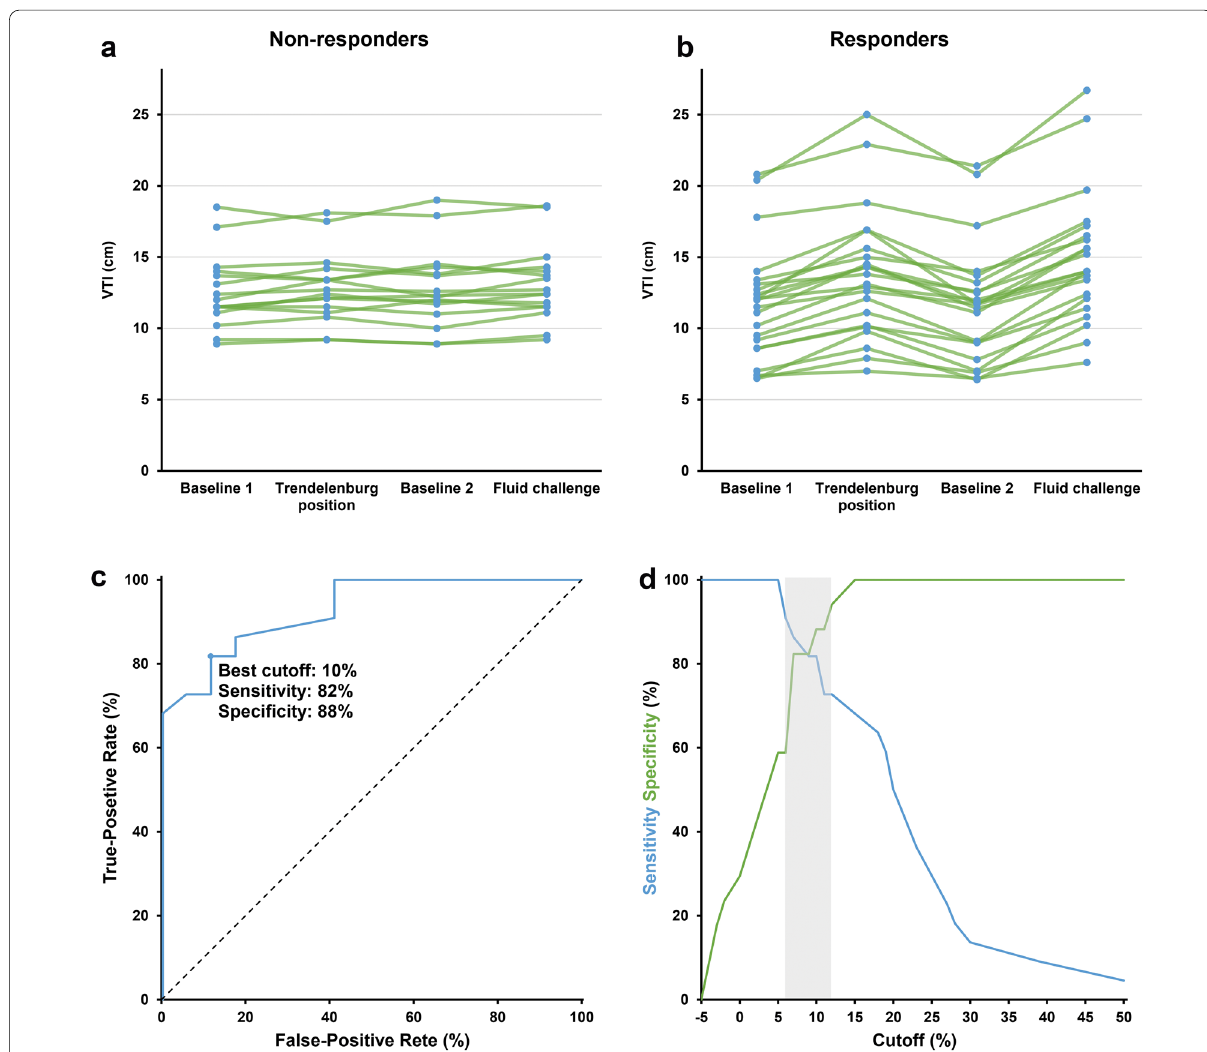
Fig. 3 Individual values of velocity–time integral (VTI) of each step in non‑responders ( a ) and responders ( b ) as well as receiver operating characteristics curve ( c ) and grey zone analysis ( d ) of changes in VTI induced by the Trendelenburg position to predict fluid